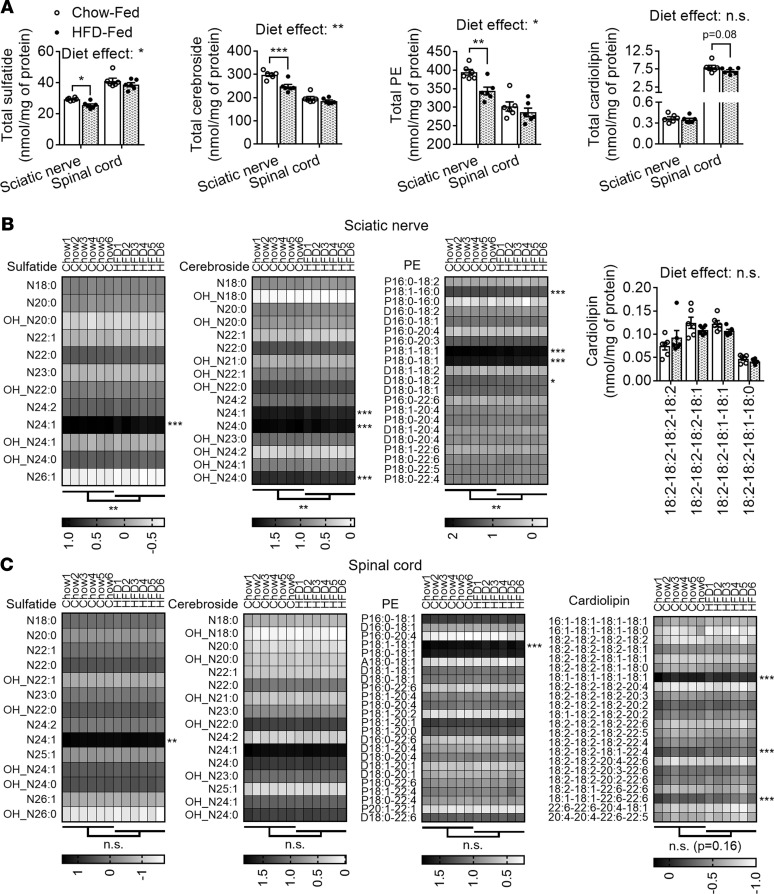
Loss of myelin lipids in diet-induced obese prediabetic mice.Sciatic nerve and spinal cord tissue from long-term HFD-fed and chow-fed controls were dissected, flash-frozen, homogenized, lipid extracted, and assessed by MDMS shotgun lipidomics. (A) Total sulfatide, cerebroside, and PE, and cardiolipin content for each dietary regimen/tissue is displayed as dot plots (chow shown with open circles/bars, HFD shown with filled circles/bars); data represent the mean ± SEM of n = 6 mice/dietary regimen for all panels. Total levels of each lipid class were compared between dietary regimens and tissues using 2-way ANOVA (genotype effect P values specified on top of each graph) and Holm-Šidák multiple-comparisons tests (adjusted P values specified on top of brackets). Sciatic nerve (B) and spinal cord (C) molecular species of each lipid class mentioned above are displayed as either dot blots with bars (sciatic nerve cardiolipin) or log-transformed gray scale heatmaps (all others). Low-abundance lipid species that made ≤1% of the total class content are not shown and were not included in statistical analyses. Although a specific mass peak may represent more than one molecular species, for simplicity heatmaps display only 1 (most common) lipid species for each mass (row). Molecular species within each lipid class were compared using 2-way ANOVA and Holm-Šidák multiple-comparisons tests on GraphPad Prism 7. Statistics displayed below the heatmaps represent global comparisons between dietary regimens, while those next to specific rows represent specific molecular species comparisons. *P < 0.05, **P < 0.01, ***P < 0.001.